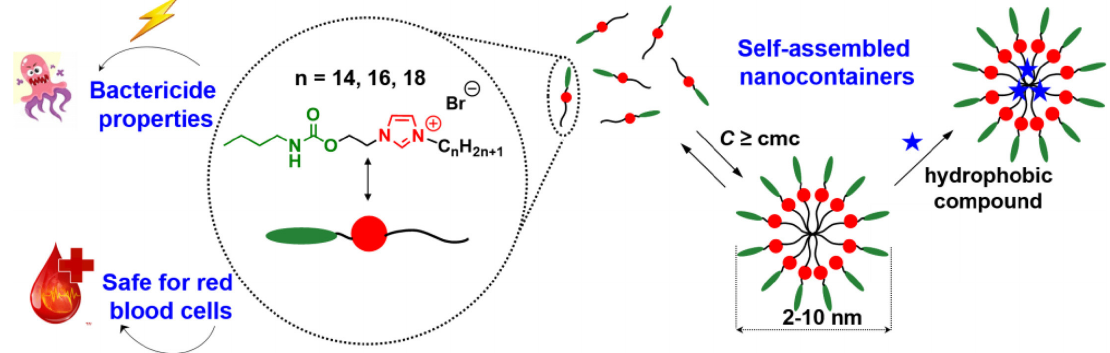
Figure 5. Some properties of carbamate surfactants with an imidazolium head group [8]. Copyright 2020